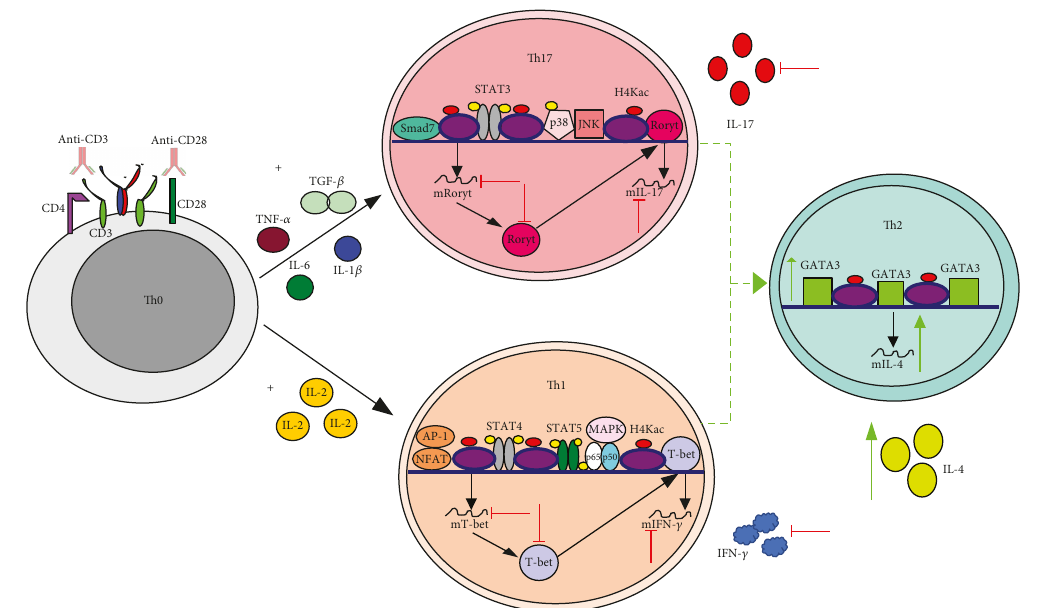
Figure 11: VPA polarizes Th1 and Th17 immune pro fi les into Th2 immune responses, both in vitro and in vivo . Th0, or naïve lymphocytes, that are activated in vitro with anti-CD3 and anti-CD28 and then polarized into Th1 with IL-2 or into Th17 with TGF- β +IL-6+TNF- α +IL-1 β and which are then treated with VPA, are polarized toward a Th2 pro fi le due to increased expression of GATA3 and IL-4. This reduces the expression levels of T-bet and IFN- γ (Th1), as well as of ROR γ t and IL-17 (Th17). This e ff ect is also found in in vivo models of EAE, as well as in graft versus host disease. Additionally, VPA also induces apoptosis in Th1 and Th17, both in vitro and in vivo (not shown). Green arrows indicate the processes, molecules, or mediators in the signaling pathway that are augmented and/or promoted by VPA. Red arrows indicate processes, molecules, or mediators in the signaling pathway that are inhibited by